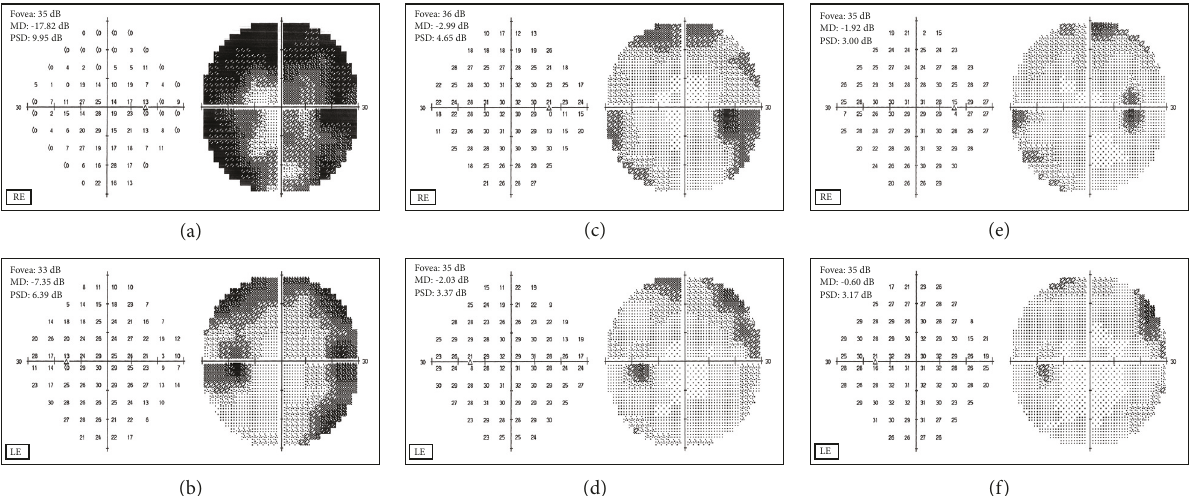
Figure 5: Patient 2. Central 30-2 visual field test recorded in March 2016 (a, b) before the start of CBS treatment, June 2016 (c,d) at the end of CBS treatment, and September 2016 (e, f) after four months from the end of CBS treatment, in right (RE) and left (LE) eye.